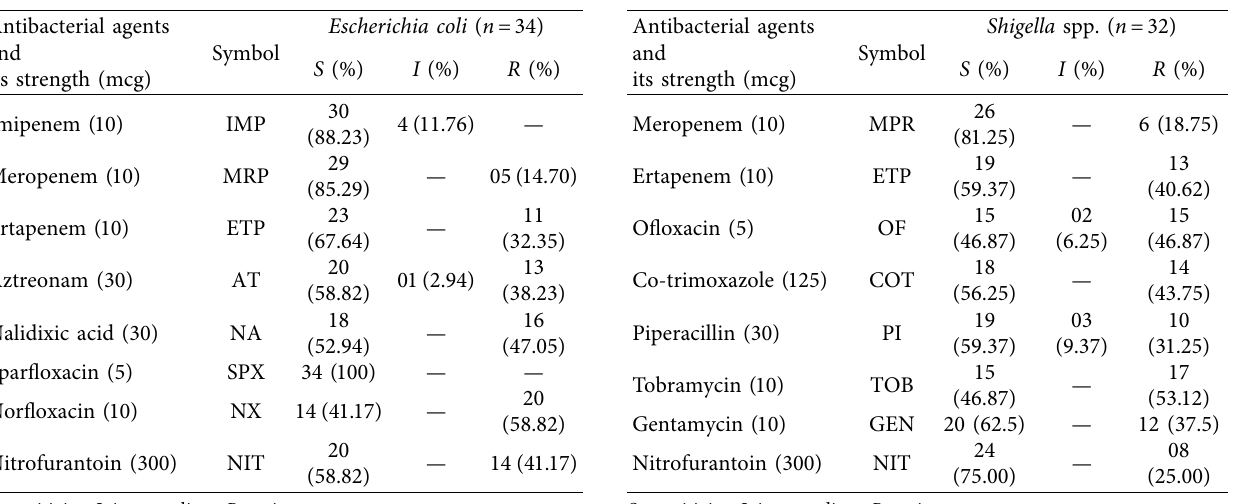
Table 3: Antimicrobial susceptibility profles of Shigella spp . at the Wolaita Sodo University wastewater treatment plant.